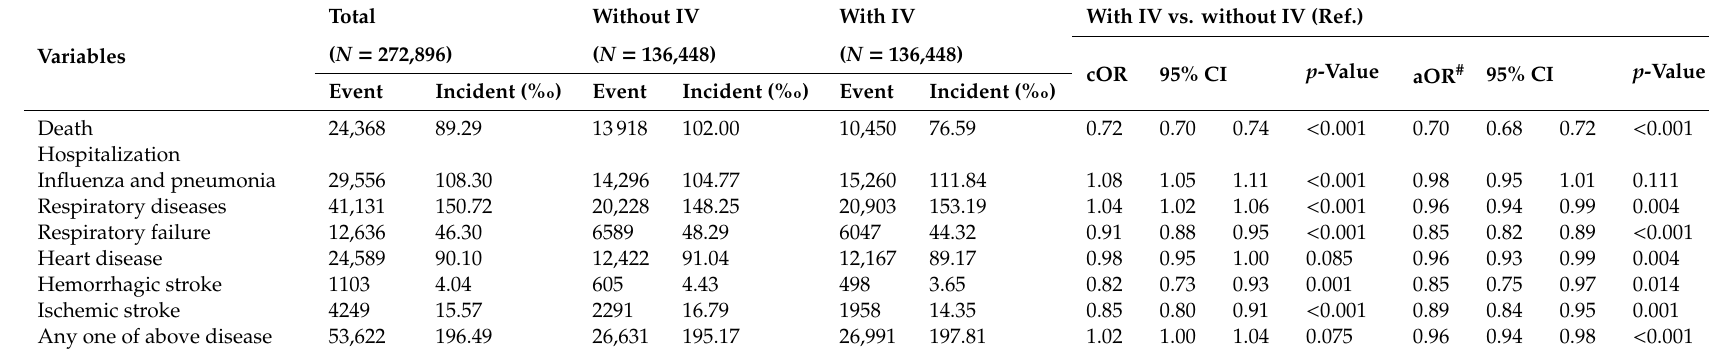
Table 1. Comparison of risks of outcomes of interest between the vaccinated and unvaccinated